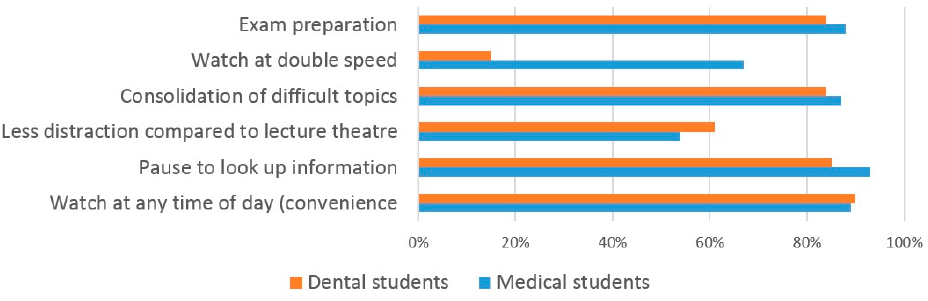
Figure 7. The reasons why students use VRL.